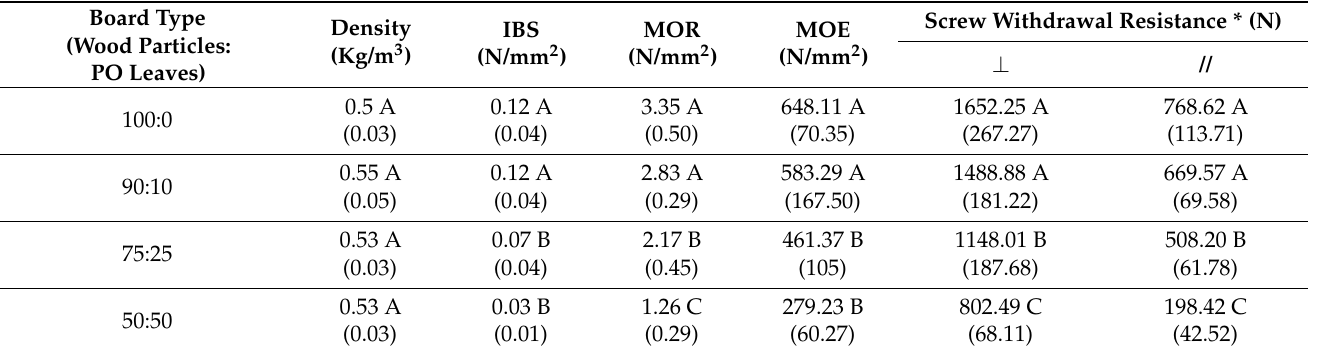
Table 1. The mechanical properties of various board types. Standard deviations are given in parentheses. The different letters show which values are statistically different at the 5% level.